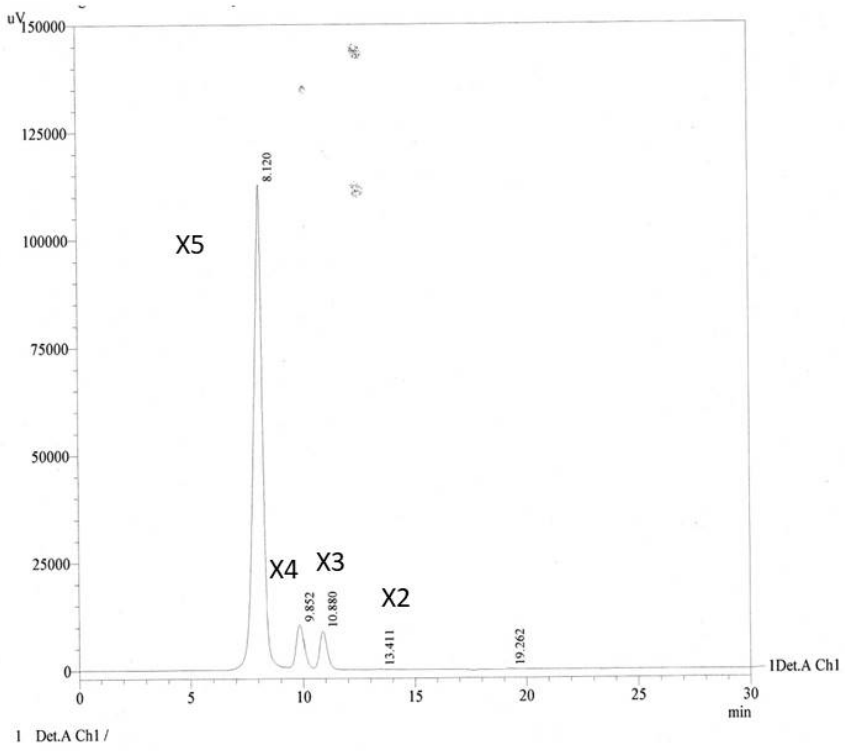
Figure 2. HPLC chromatogram of XOS from enzymatic hydrolysis of cassava pulp xylan by endo-1.4-D-xylanase, Xn indicates the xylose subunits in the oligomers.